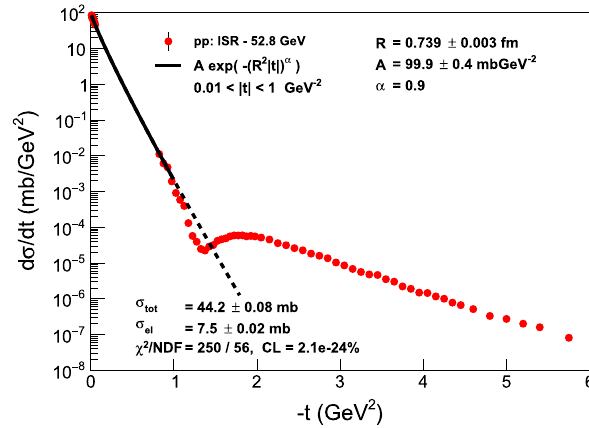
Fig. 39 Zeroth-order Lévy fits to the cone region of the differential √ s = 23 . 5 GeV [45], cross-section data on pp elastic scattering at with fixed α = 0 . 9, A and R being free fit parameters